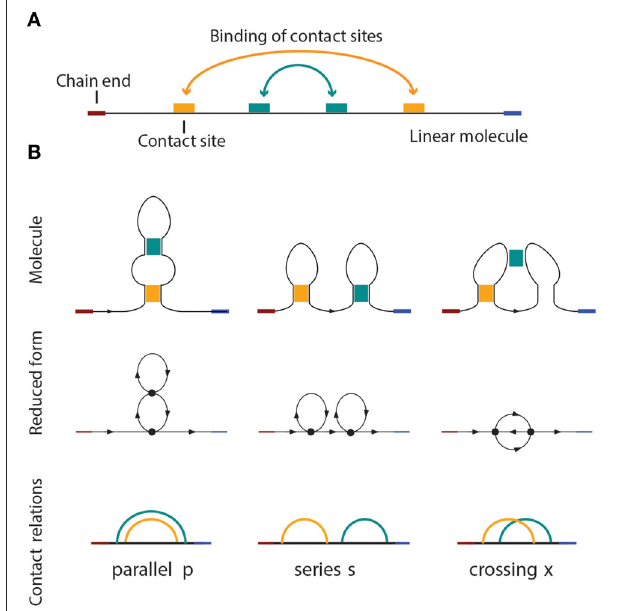
FIGURE 1 | (A) A linear molecule with four contact sites. The two chain ends are distinguishable in linear biomolecules like nucleic acids and proteins. The curved arrows show how the molecule folds, i.e., four contact sites merge into two binary contacts. The arrangement is parallel in this case, as shown in (B) , on the left side. (B) Three basic circuit relations between two contacts in a linear molecule. From left to right: parallel, series, and